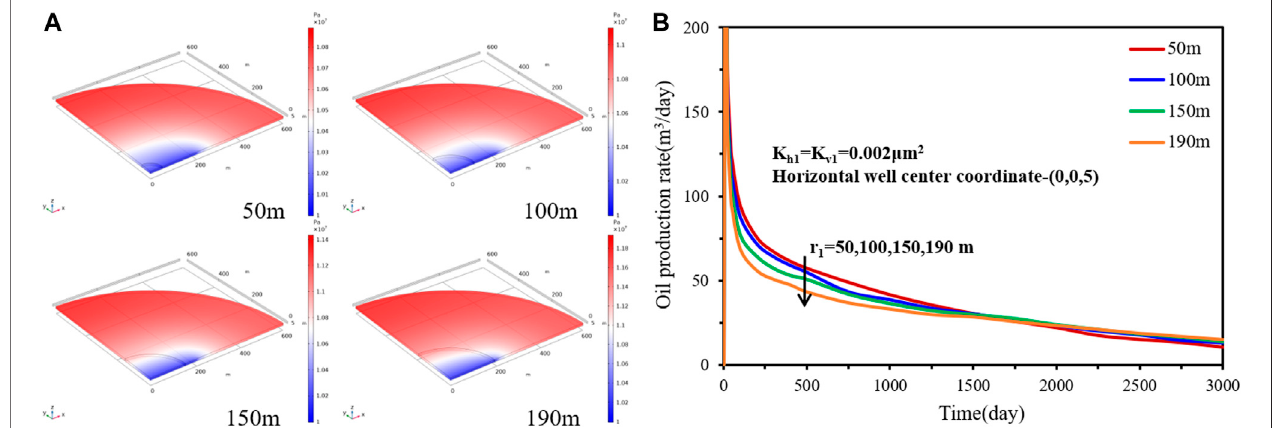
FIGURE 7 | Effect of inner region radius on (A) transient pressure and (B) rate decline performance.